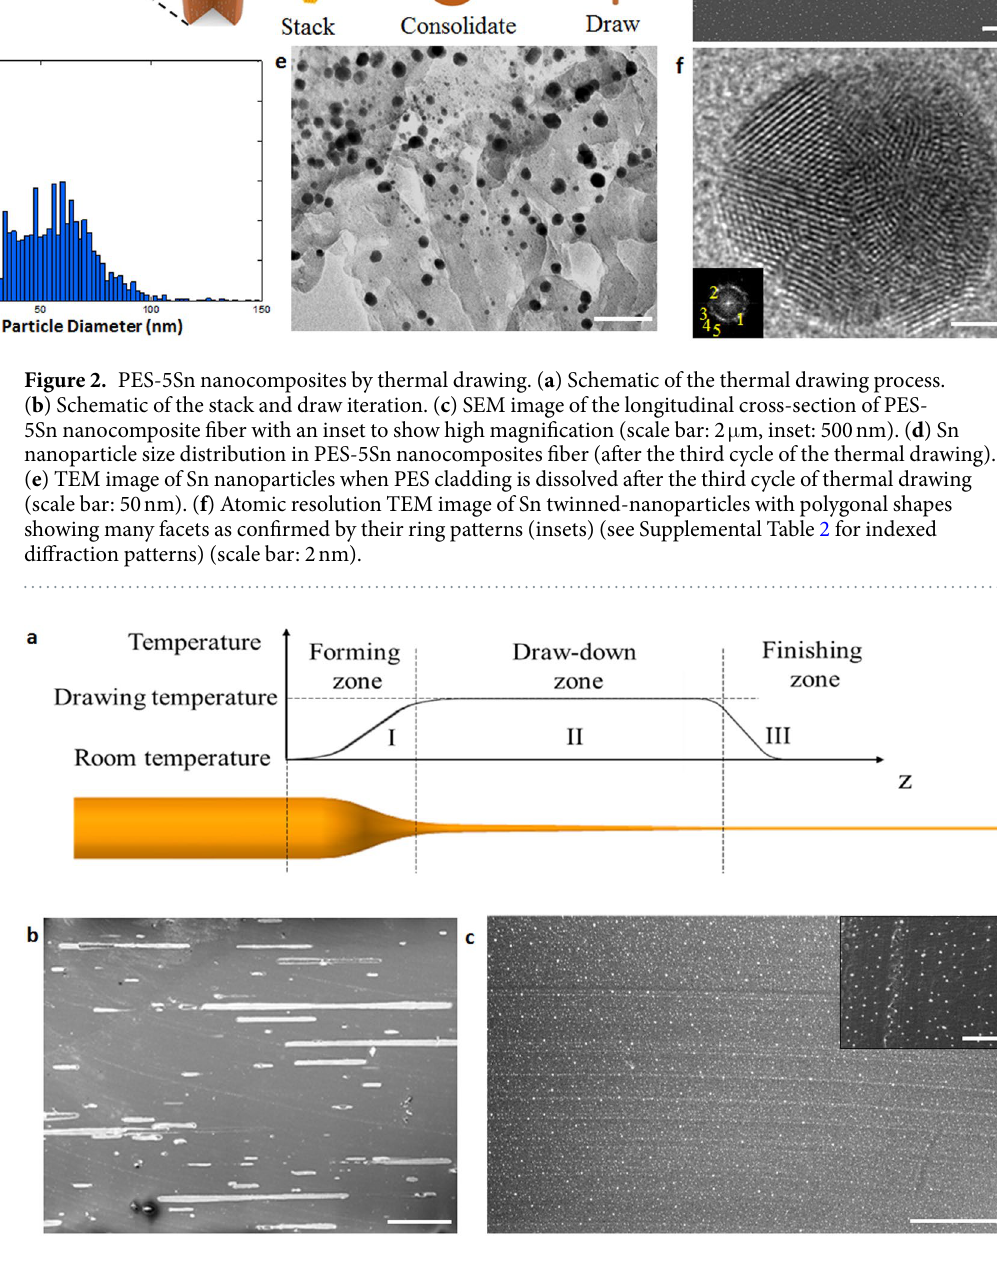
Figure 3. Metal droplet deformation during thermal drawing. ( a ) Evolution of metal droplet/wire during cyclic thermal drawing. ( b ) SEM image of the composite fiber longitudinal cross-section after several consecutive cuts were made on the fiber surface (after first thermal drawing cycle) (scale bar: 50 μ m). ( c ) SEM images of a thin film cut from the PES-5Sn nanocomposite fiber (after the third cycle of the thermal drawing) with an inset to show high magnification (scale bar: 5 μ m, inset: 1 μ